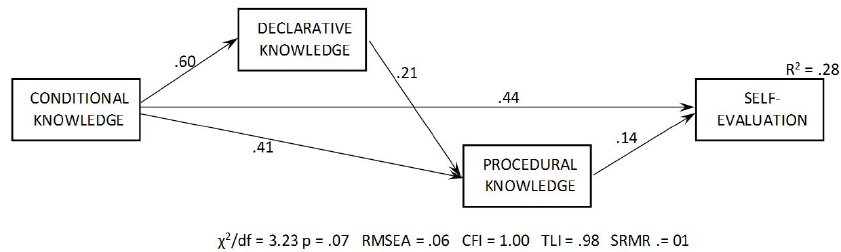
Figure 3. A model of the knowledge of